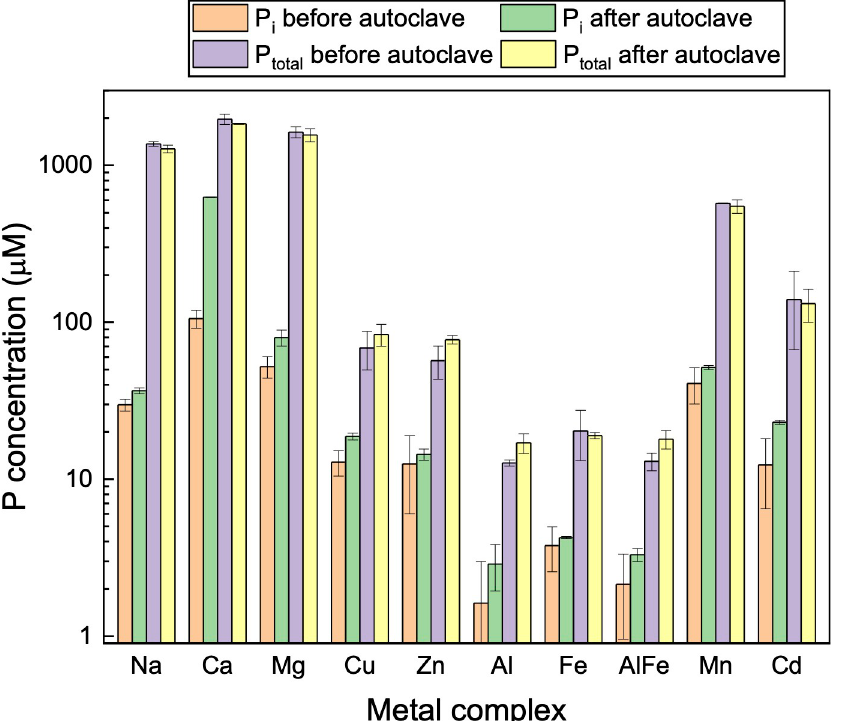
Fig 4. Thermal stability of anhydrous metal phytate complexes in autoclave treatment (at 121˚ C and 15 psi). The initial concentration of metal phytate complex was 300 mg/L (about 0.227–0.397 mM of phytate or equivalent of 1.38– 2.38 mM phytate-P) in each experiment. Different P measurements and calculations are the same as in Fig 3.